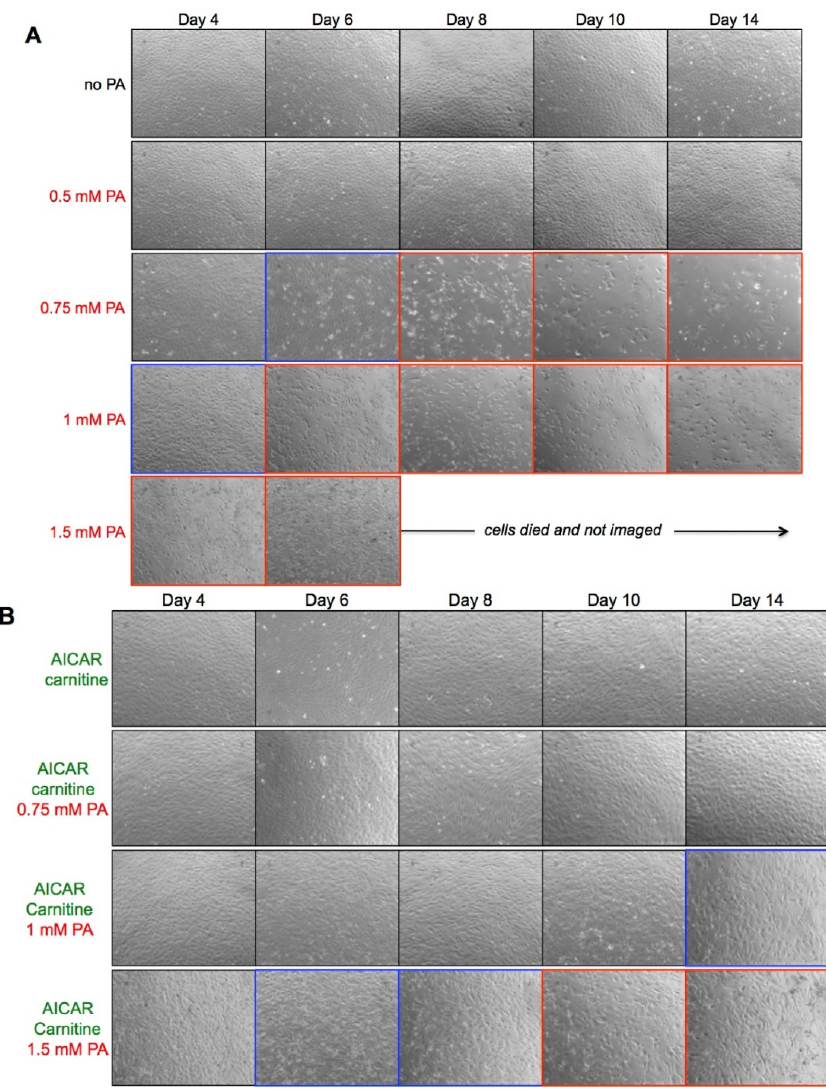
Figure 1. HUVEC viability is decreased by palmitate and rescued by AICAR/carnitine. The cells were cultured in EGM with different PA concentrations in absence ( A ), or presence of 40 µ M carnitine and 1 mM AICAR ( B ) as indicated on the left. The medium was exchanged daily and HUVEC monolayers were examined by phase-contrast microscopy at the time points indicated on the top. Shown are the representative 10 × images from 2 independent experiments. Blue frames mark the onset of apparent changes in cell monolayers, whereas the red frames denote clearly impaired cell monolayers. Full size annotated images corresponding to HUVEC + 0.75 mM PA, days 4–14 and to HUVEC + 0.75 mM PA, 1 mM AICAR/carnitine, days 4–14 could be found in Supplementary Materials. Other images are available on